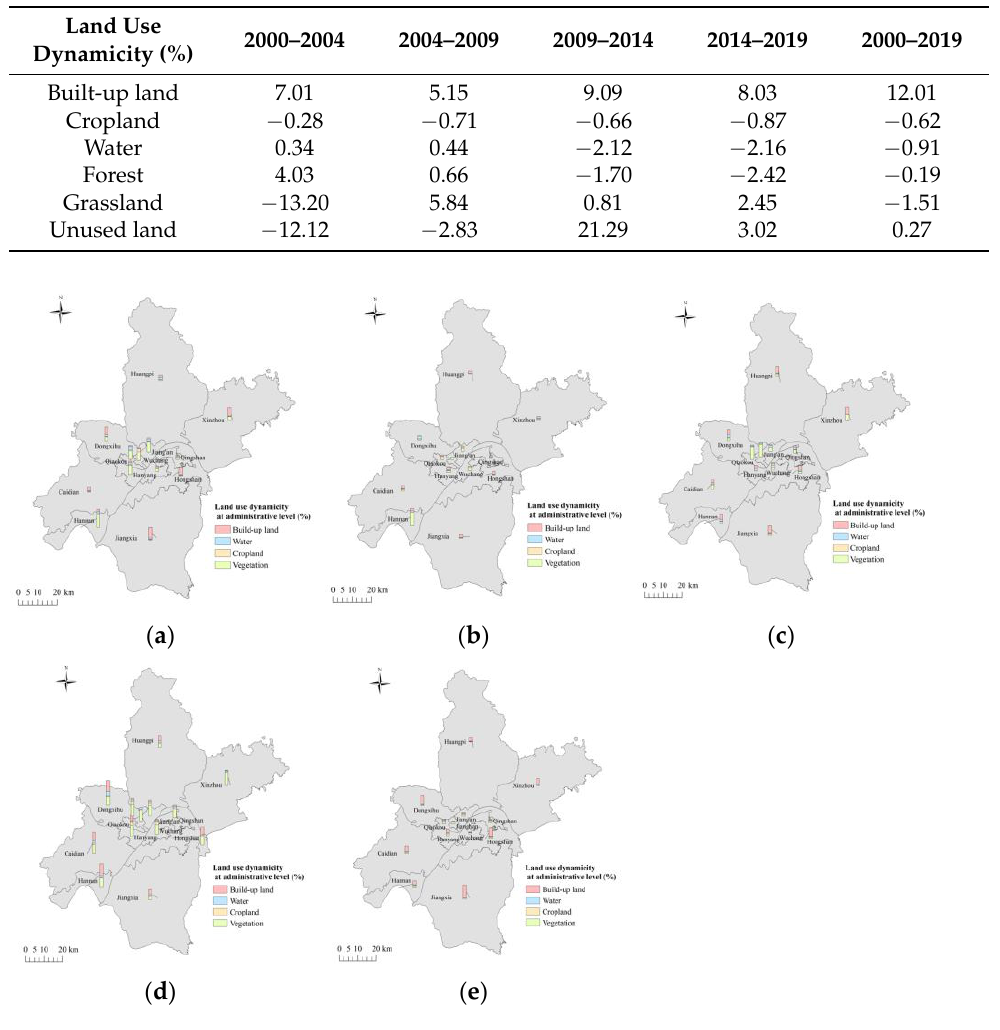
Figure 8. The spatial pattern of single land use dynamicity of different districts in various periods: single land use dynamicity pattern during the period ( a ) 2000–2004; ( b ) 2004–2009; ( c ) 2009–2014; ( d ) 2014–2019; and ( e )